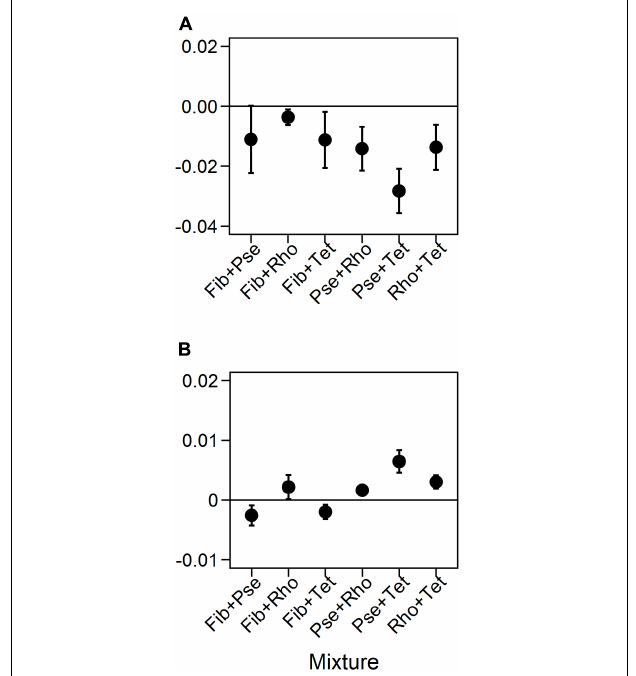
FIGURE 7 | Slopes from the relations between fluctuation frequency and responses in maximum growth rates (A) and carrying capacities (B) of the two-species mixtures. Error bars represent standard